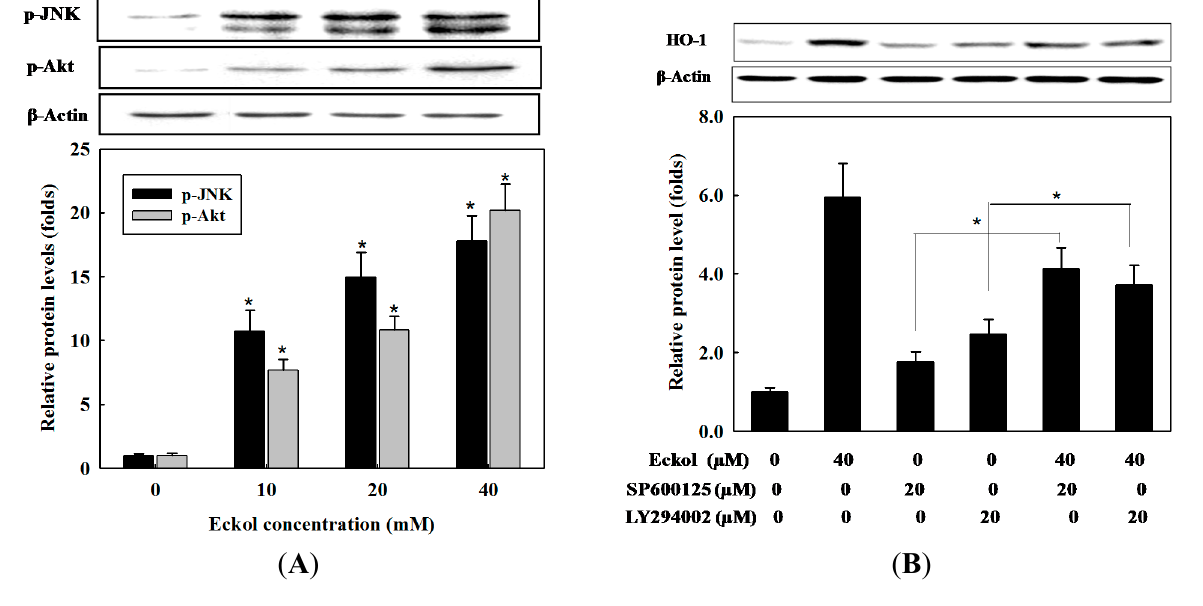
Figure 5. Effect of eckol on the phosphorylation of JNK and Akt in HepG2 cells. ( A ) Cells were treated with indicated concentrations of eckol for 1 h. Whole cell protein was analyzed by Western blot using anti-p-JNK and anti-pAkt; ( B ) Cells pretreated with or without SP600125 or LY294002 for 1 h were stimulated with eckol for 16 h. Whole cell protein was used for the detection of HO-1 using Western blot; ( C ) Cells pretreated with indicated concentrations of eckol or inhibitors for 1 h and then treated with 0.5 mM H 2 O 2 for 24 h. The cell viability was determined by MTS assay kit. Values are the mean ± SD of three independent experiments. * p < 0.05 indicates significantly differences between